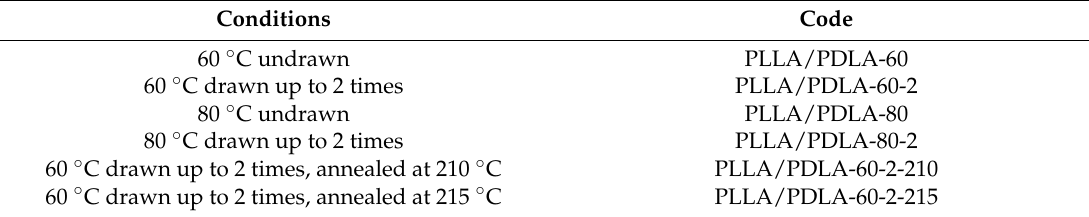
Figure 1. Temperature/draw procedure for in situ WAXS. Table 1. Code of PLLA/PDLA blend